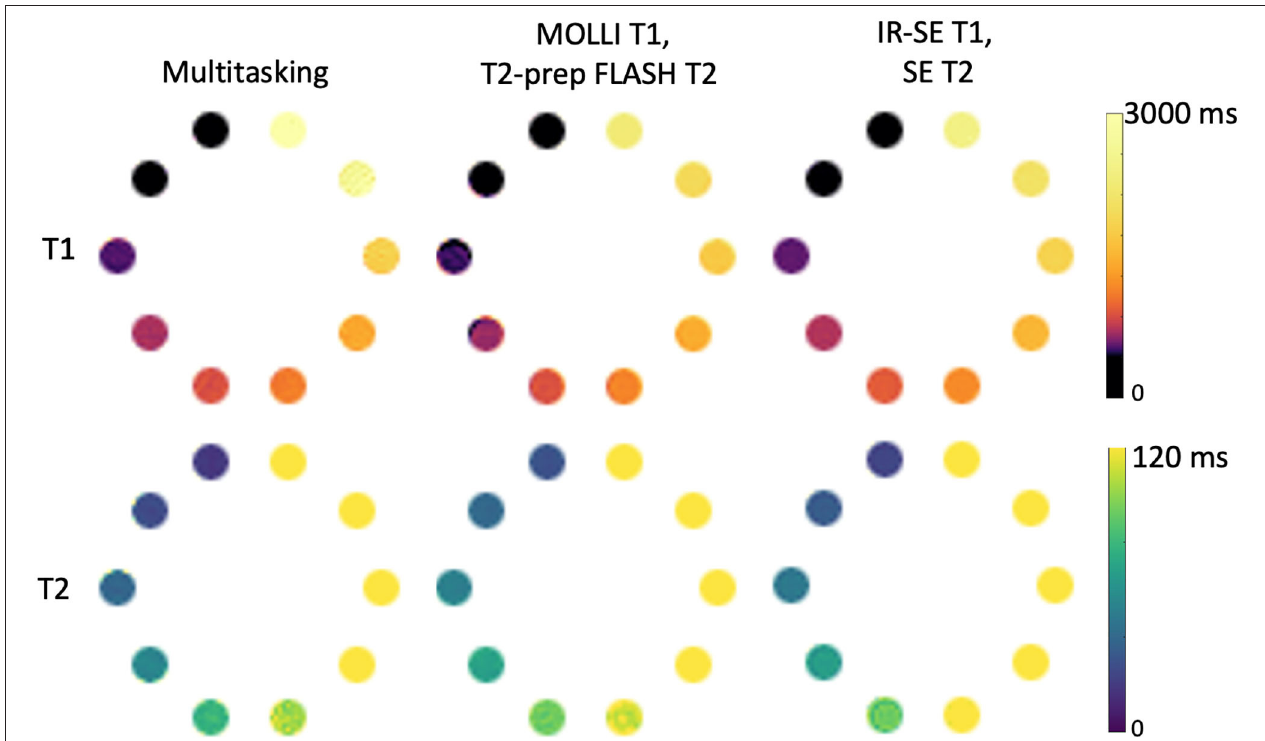
FIGURE 3 | T1 and T2 measurements of the ISMRM/NIST phantom using the Multitasking-SMS method and the reference methods [modified look-locker inversion recovery (MOLLI), T2-prep FLASH methods; IRSE-T1 and SE-T2 methods]. 8 vials with T1 < 2,000ms are used for T1 analysis, and 5 vials with T2 < 120ms are used for T2 analysis.